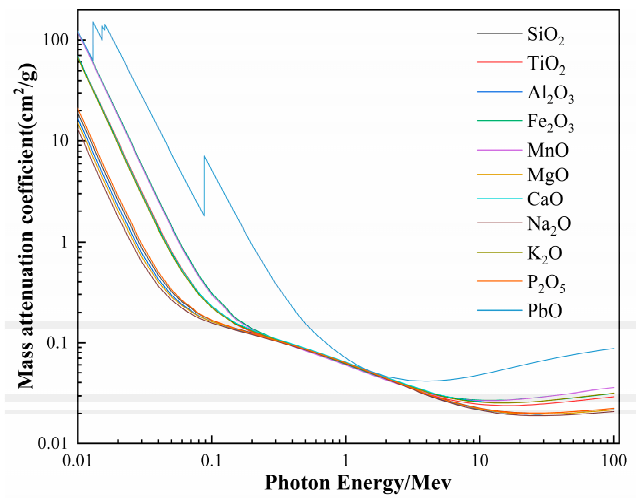
Figure 3. Basalt fiber oxide and PbO mass attenuation coefficient.